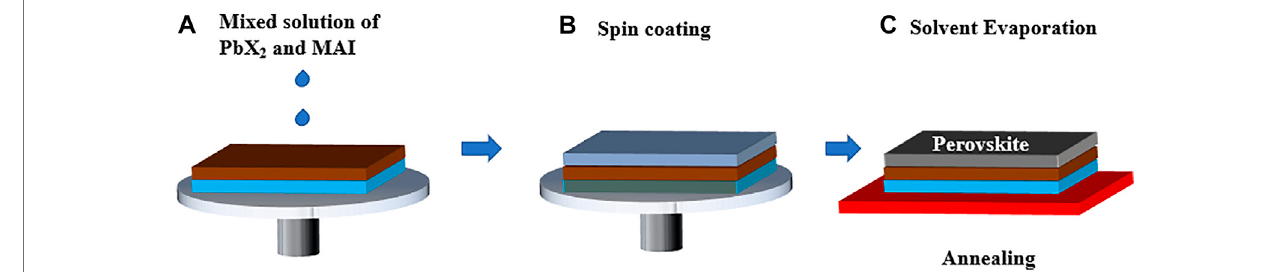
FIGURE 2 | Schematic illustration of obtaining a perovskite layer by one step deposition method.